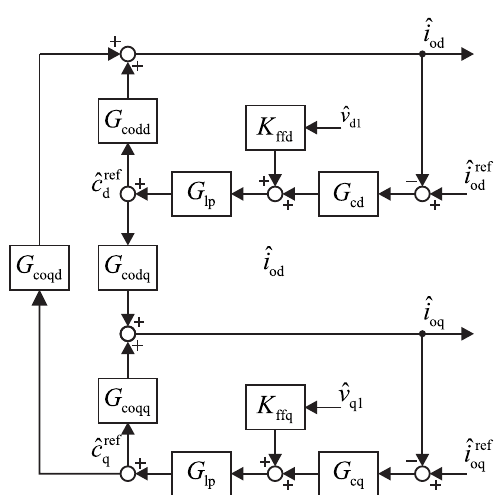
Figure 6. Current control dynamics.